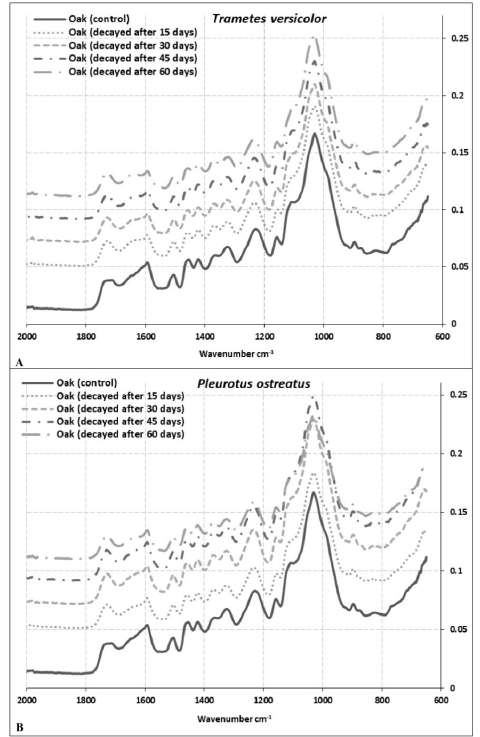
Figure 5. Total FT-IR spectra of oak wood samples exposed to T. versicolor ( A ) and P. ostreatus ( B ) for 60 days. Table 1. FTIR Peak assignments in Spruce-, (1); Beech (2) and Oak control woods (3). Peak No.